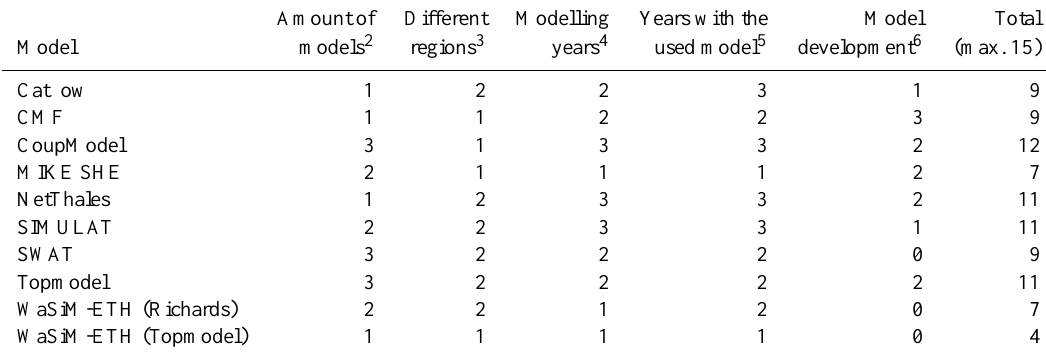
Table 7. Indexed experience of the modeller 1 .